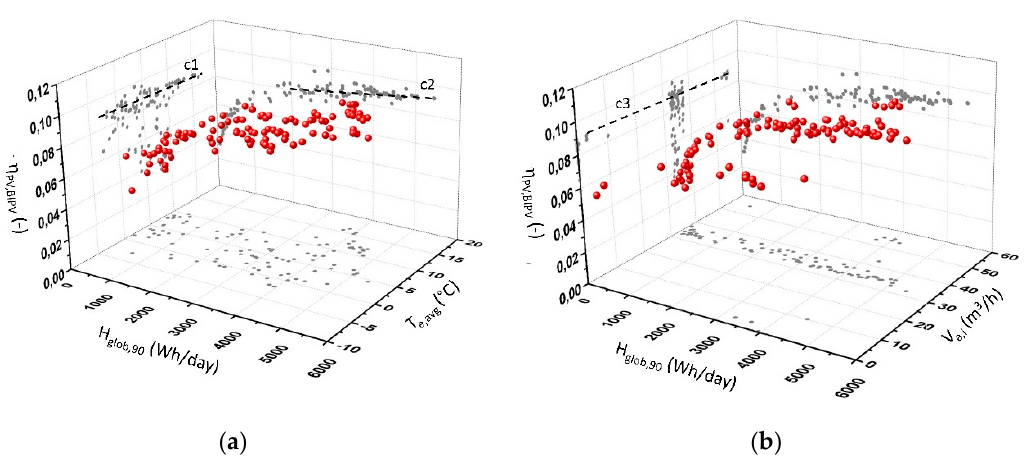
Figure 11. Average daily efficiency of electricity production by glazed BIPV determined considering that surface area of PV cell in glazed BIPV is 60%; ( a ) impact of the daily solar radiation H glob,90 and average daily outdoor air T e,avg ; ( b ) impact of the solar radiation and  ventilation air flow rate , a in V